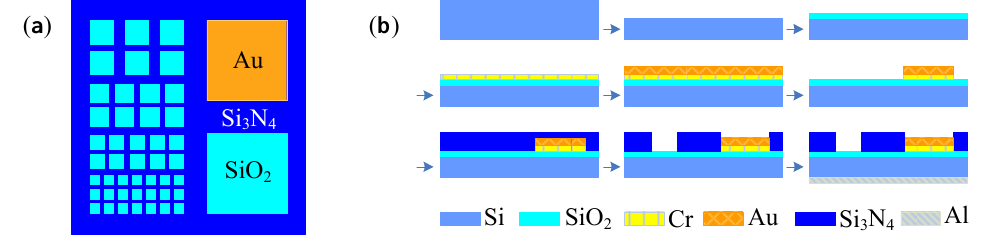
Figure 25. Schematic diagram of an integrated photovoltage-based biosensor used for cellular detection. ( a ) Sensor design; ( b ) Sensor